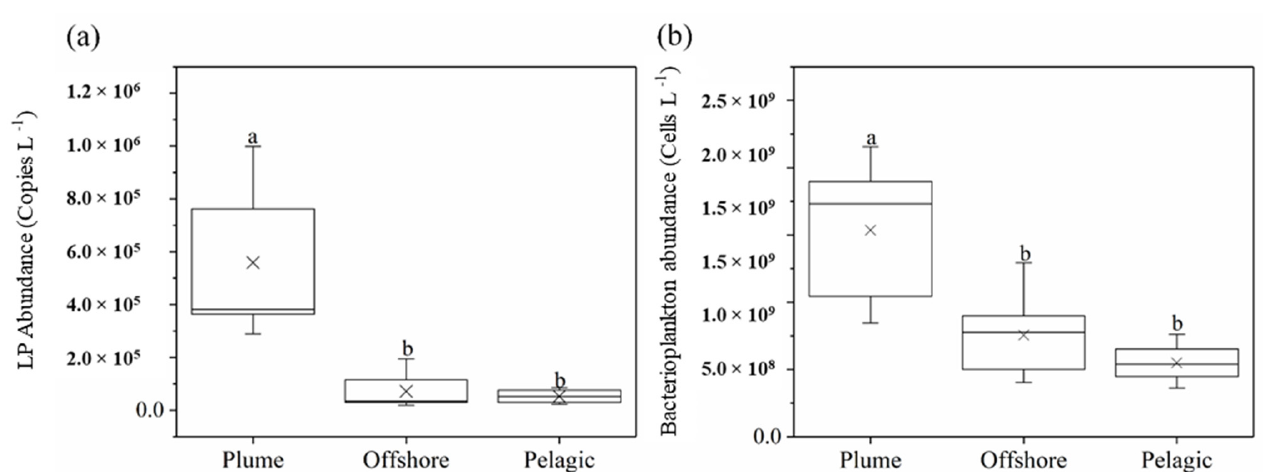
Figure 2. Abundances of LP ( a ) and bacterioplankton ( b ) along a plume to pelagic gradient in the South China Sea in 2016 and 2018. Statistical analysis was done by Pairwise.wilcox test after the Kruskal–Wallis test. The multiplication sign inside each box represents the median. The significant differences of different habitats were indicated with different letters.